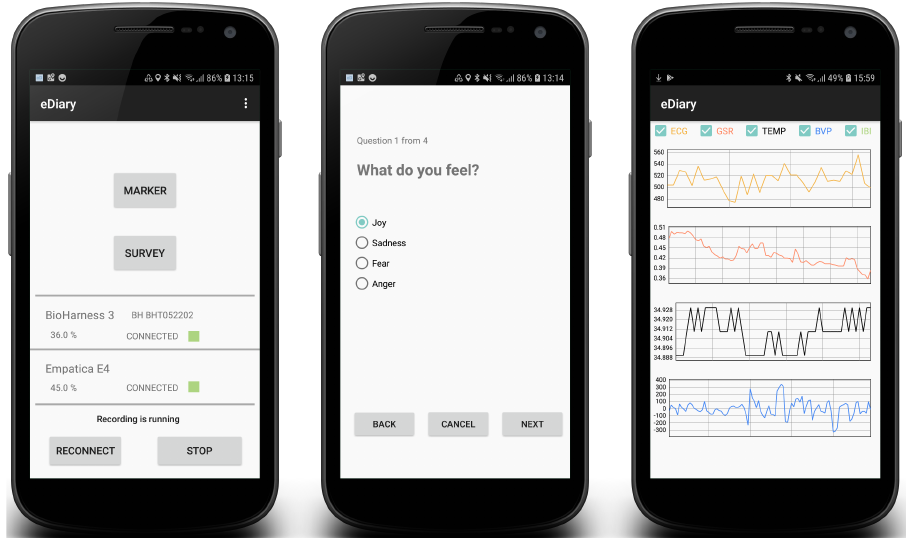
Figure 4. Overview of the eDiary